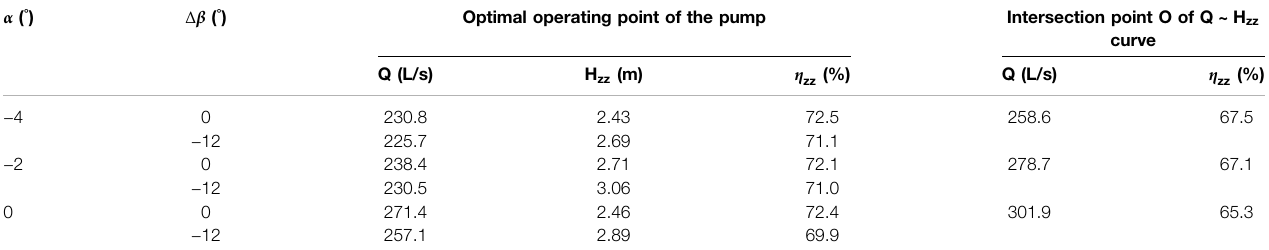
TABLE 4 | Comparison of performance parameters at main operating points of the pump devices. Optimal operating point of the pump